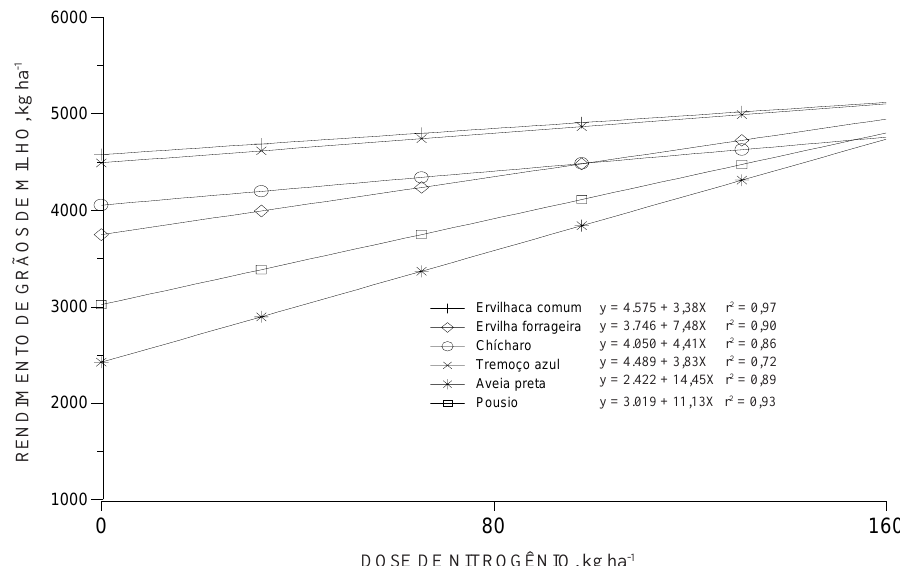
Figura 3. Relação entre dose de nitrogênio e rendimento de grãos de milho cultivado em sucessão a plantas de cobertura de